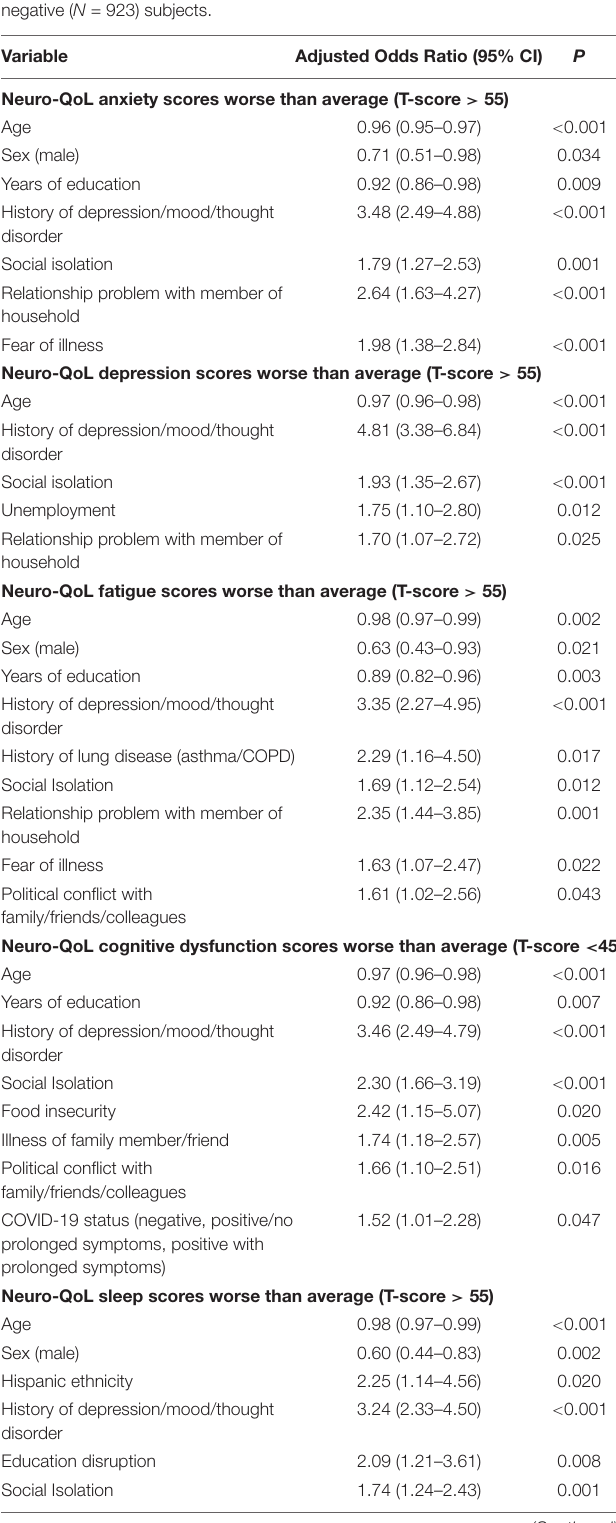
TABLE 4 | Multivariable logistic regression models predicting worse than average Neuro-QoL metrics among subjects with prolonged COVID-19 symptoms ( N = 19), COVID-19 without prolonged symptoms ( N = 57), and COVID-19 negative ( N = 923)